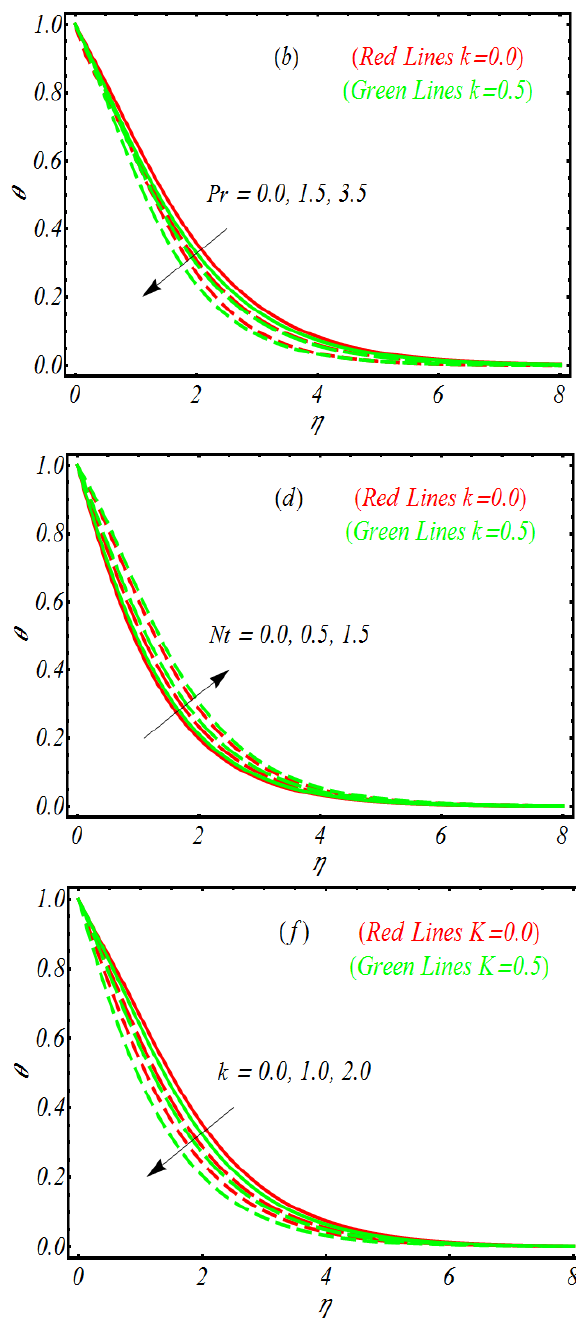
Figure 2. Temperature profile for ( a ) K , ( b ) Pr, ( c ) ε , ( d ) Nt , ( e ) Nd and ( f ) k In order to look the significance of solutal concentration profile s for combined pa- rameter , H a vortex viscosity parameter , K Dufour Lewis number L d and regular Lewis number L e for two different values of k i.e., 0 . 0 k = and 0 . 5 , k = d are suggested. Figure 3a reveals that solutal concentration profile s gets maximum val- ues for H a for both 0 . 0 k = and 0 . 5 . k =